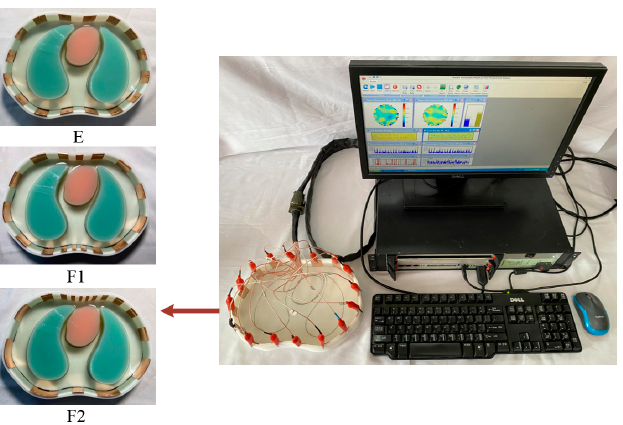
Figure 9. Experiment equipment consisting of the designed sensor and data acquisition